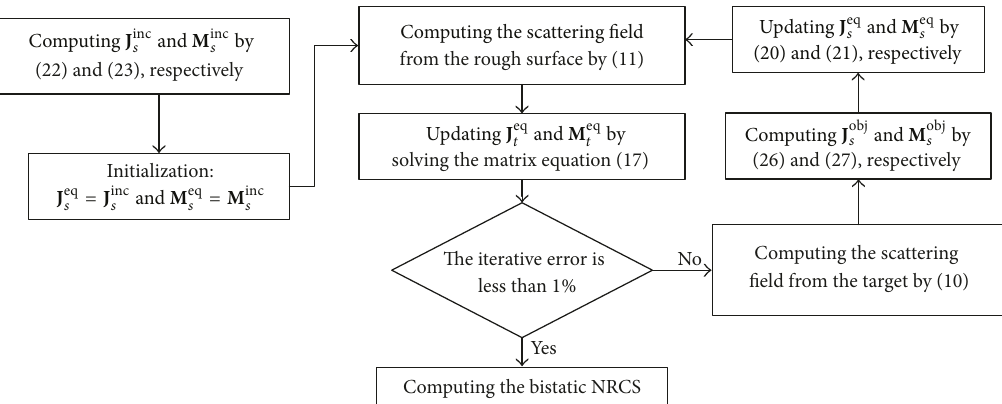
Figure 2: The flowchart of the iterative